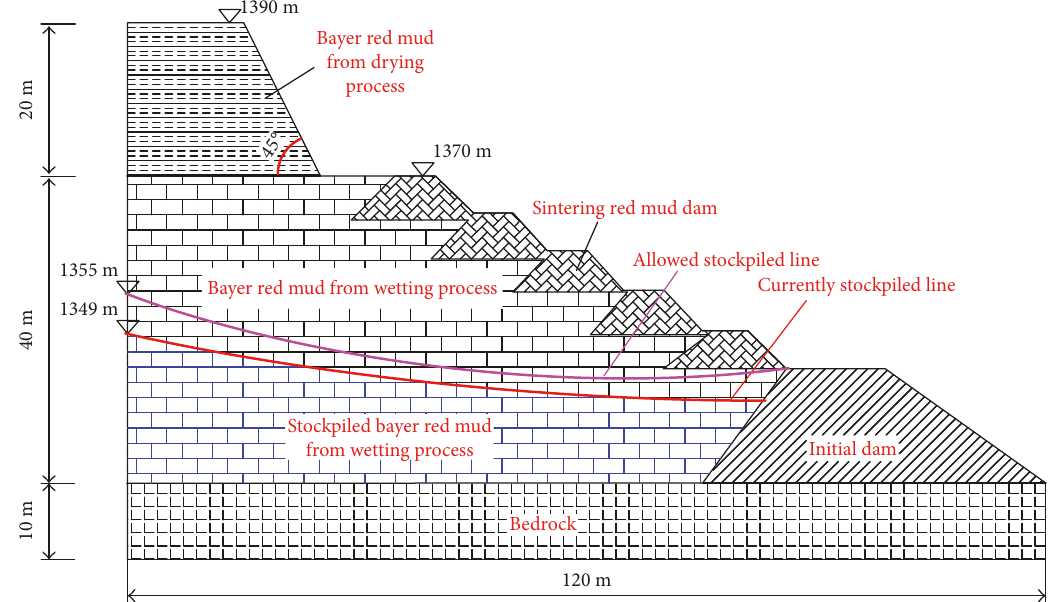
Figure 1: Design scheme of red mud stockpile dilatation.